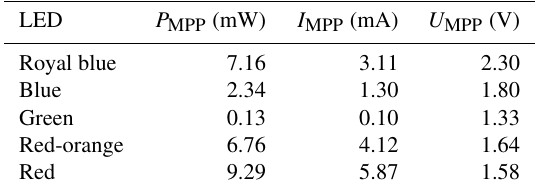
Table 5. Maximum power, current and voltage.